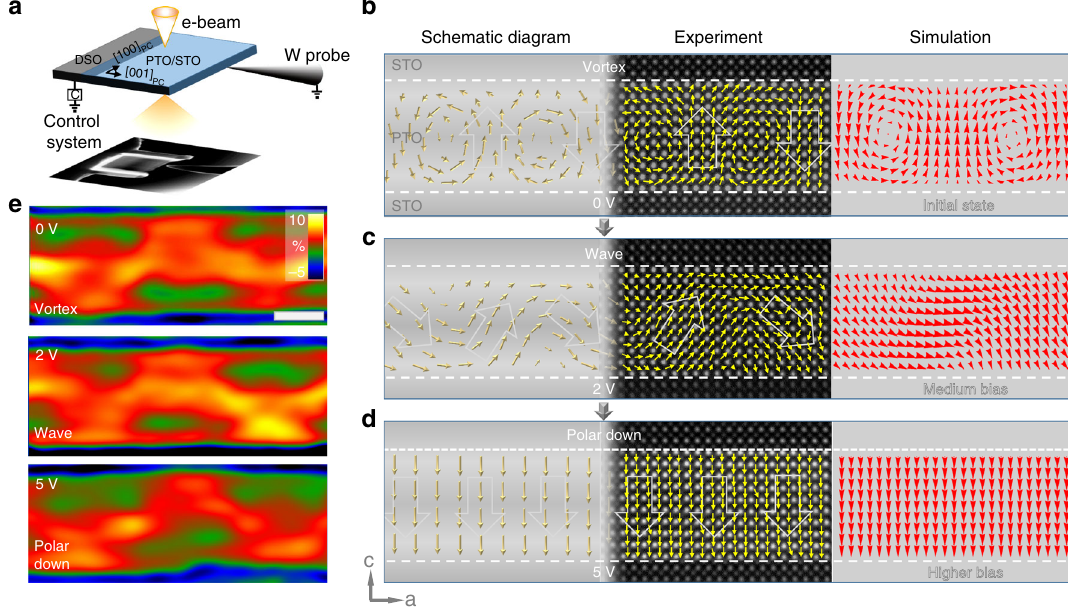
Fig. 2 Manipulation of the ferroelectric domain in a PTO/STO multilayer. a Schematic diagram of the in-situ electric fi eld experiment. The input voltage is applied along the c -axis. To capture the structural changes, a real-time analysis is performed in STEM mode. b – d Mapping of the real-time dynamic evolution of the polarization based on HAADF images under an external electric fi eld and the corresponding simulation results. An evolution process of the polar structure from vortex to wave and fi nally polar down state was recorded. The three columnar sub-panels are schematic diagrams, experimental mappings of polar vector and phase- fi eld simulations, respectively. e The out-of-plane strain ( ε yy ) map of the PTO layer under different external bias, which remain almost unchanged. Scale bar, 2